Question: Identify the chart type used in this figure.
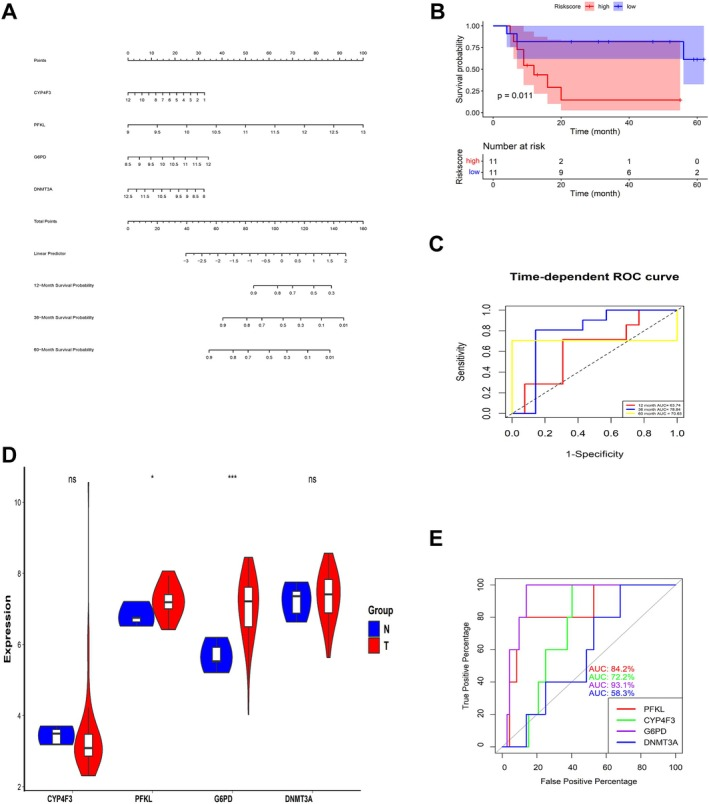
Answer: survival